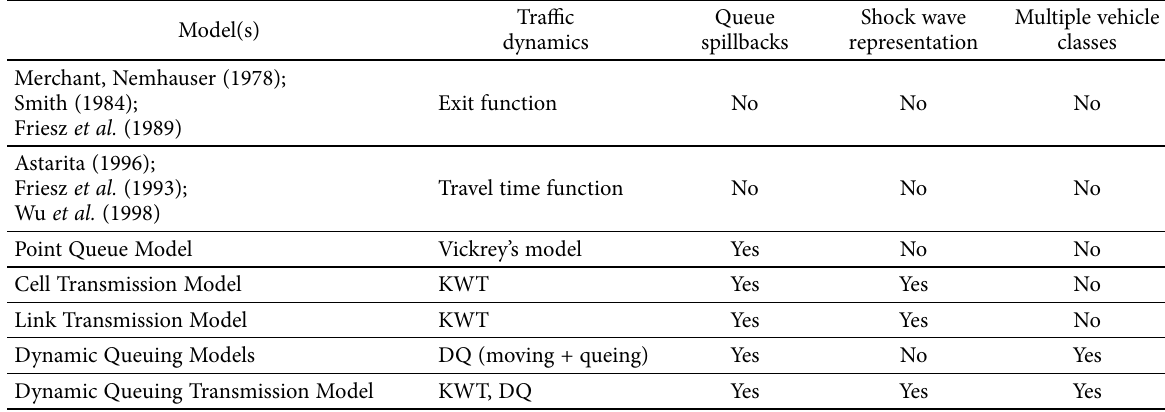
Table 1. Overview of DNL